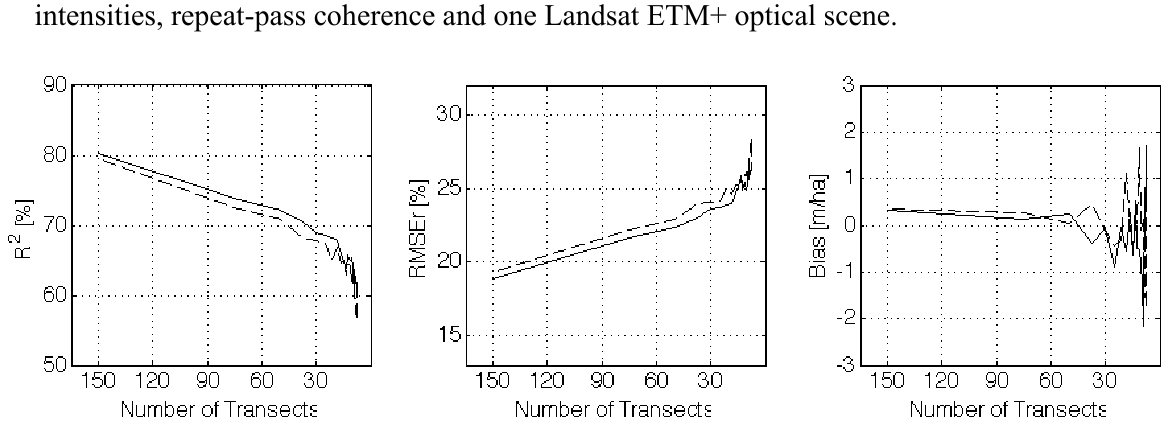
Figure 11. Effect of ALS sampling density on the retrieval performance when extrapolating from 600m wide ALS transects to entire ALOS frames using multi-temporal intensities, repeat-pass coherence and one Landsat ETM+ optical